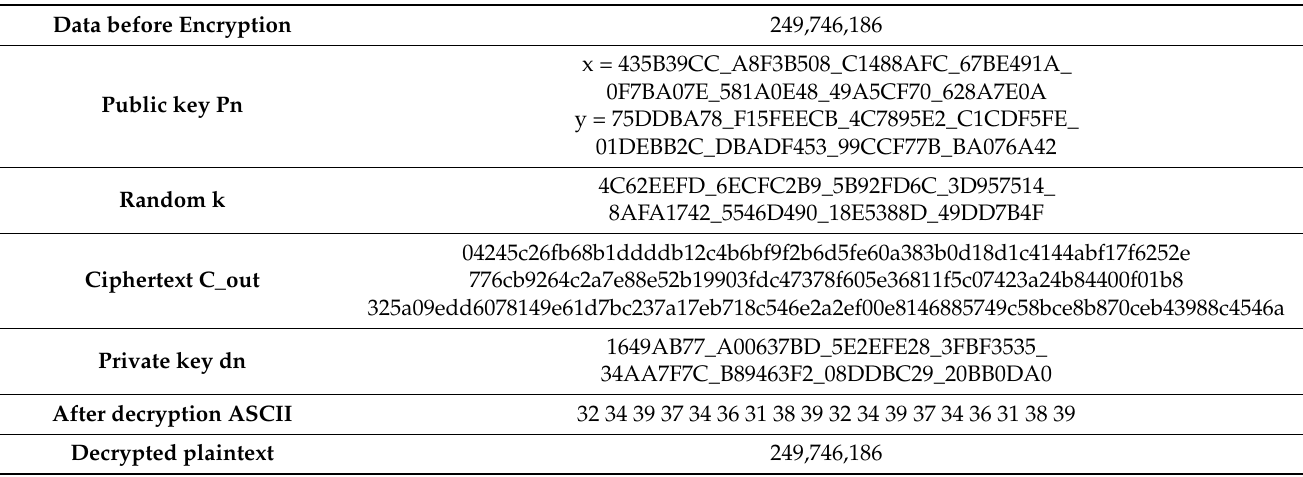
Table 2. Encryption and decryption data table via 50 km optical fiber